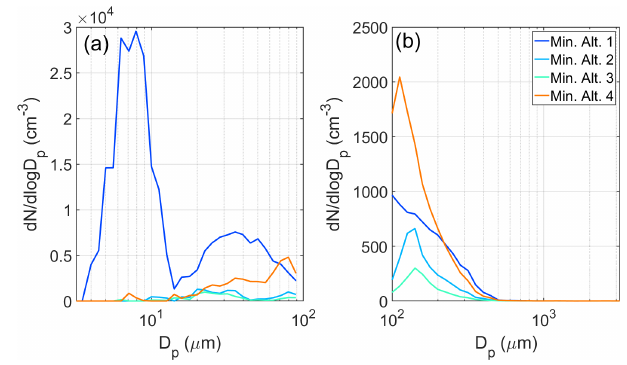
Figure 11. Aerosol size distribution comparison ( a SMPS and b LAS) between the four HU-25 Falcon min. alt. legs during ACTI- VATE Research Flight 6, as shown in Fig.